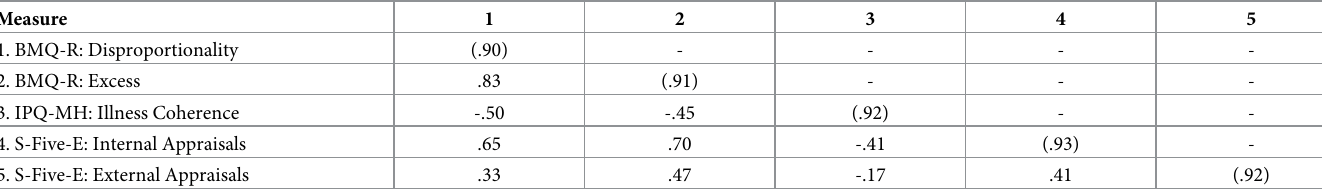
Table 7. Latent intercorrelations for recognition of excess and disproportionality with convergent measures.